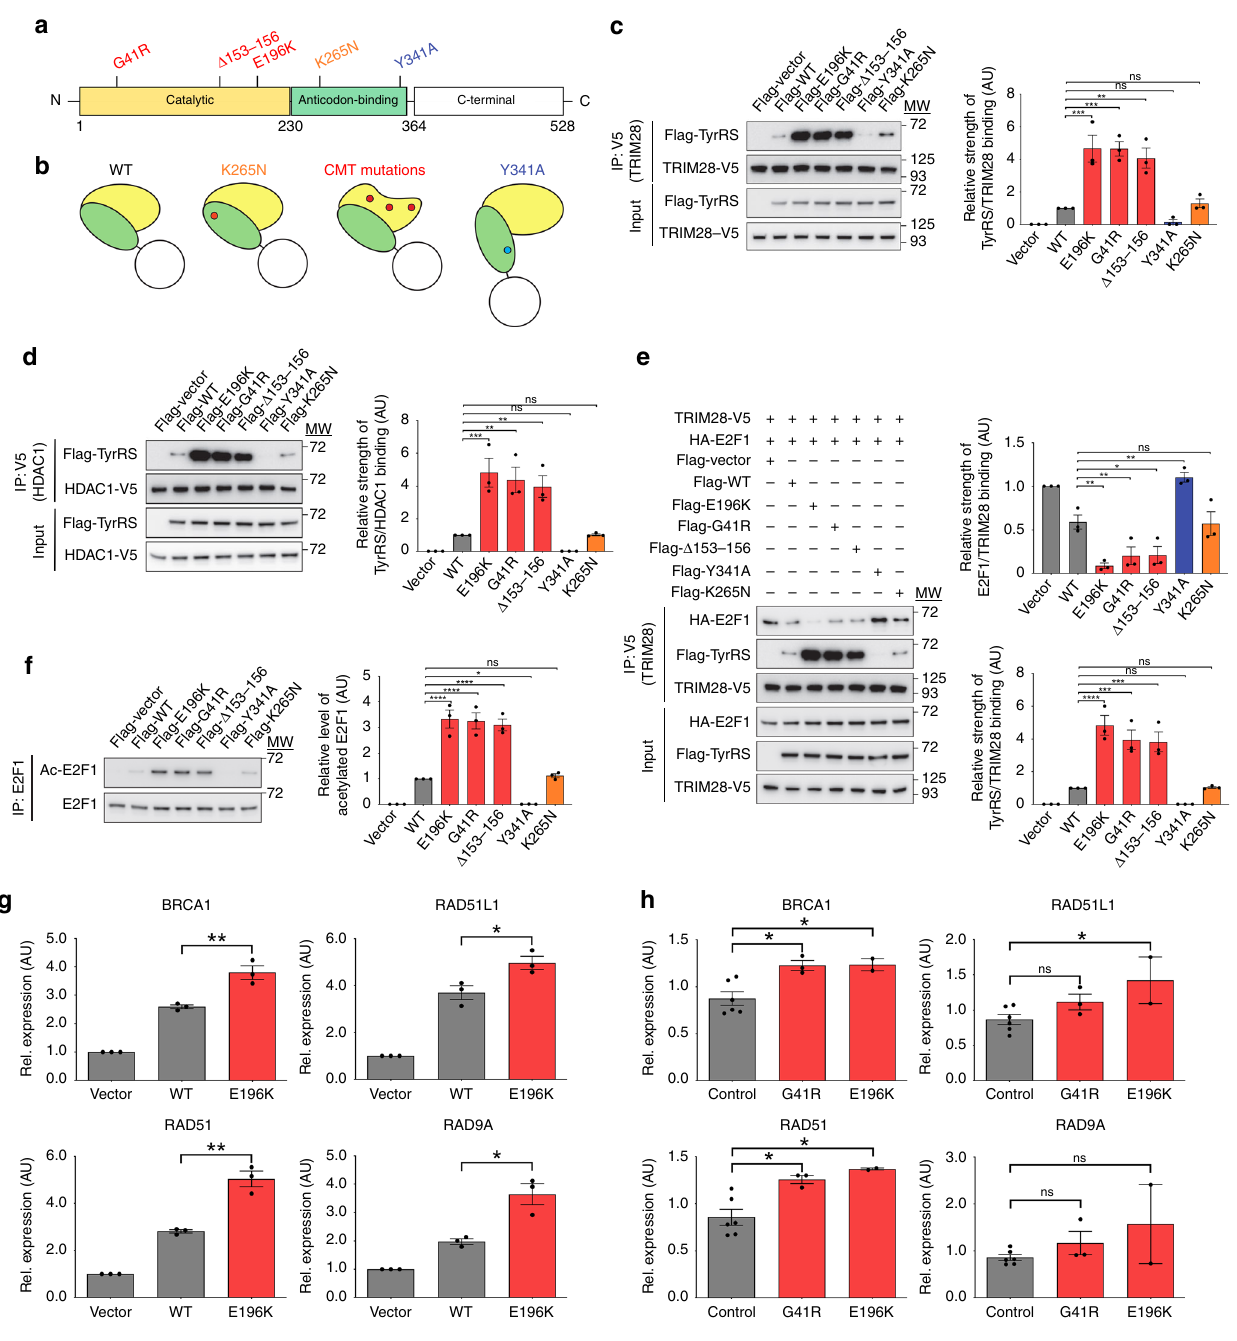
Fig. 1 TyrRS mutations induce structural changes leading to aberrant transcription regulation. a Domain structure of human TyrRS and the location of the different mutations. Red indicates CMT-causing mutations, blue indicates the cytokine-activating Y341A mutation, and orange indicates the benign substitution K265N. b Schematic illustration of the conformational changes induced by the different mutations in TyrRS. c, d Interaction of TyrRS with TRIM28 ( c ) and HDAC1 ( d ) detected by Co-IP in HEK293T cells expressing different TyrRS proteins. e Immunoprecipitation of TRIM28 and the associated binding of E2F1 to the regulatory complex upon expression of different TyrRS alleles. f Acetylation levels of E2F1 after IP in HEK293T cells expressing TyrRS. One-way ANOVA with Dunnett Multiple Comparisons test. g , h Expression of E2F1 target genes ( BRCA1, RAD51, RAD51L1 , and RAD9A ) in HEK293T cells expressing different TyrRS alleles ( g ), and patient-derived and control PBMCs ( h ). G41R ( n = 3 individuals), E196K ( n = 2 individuals), and control ( n = 5 individuals). n = 3 independent biological replicates, unpaired t -test. Bar charts are presented as means ± s.e.m. Source data are provided as a Source Data fi